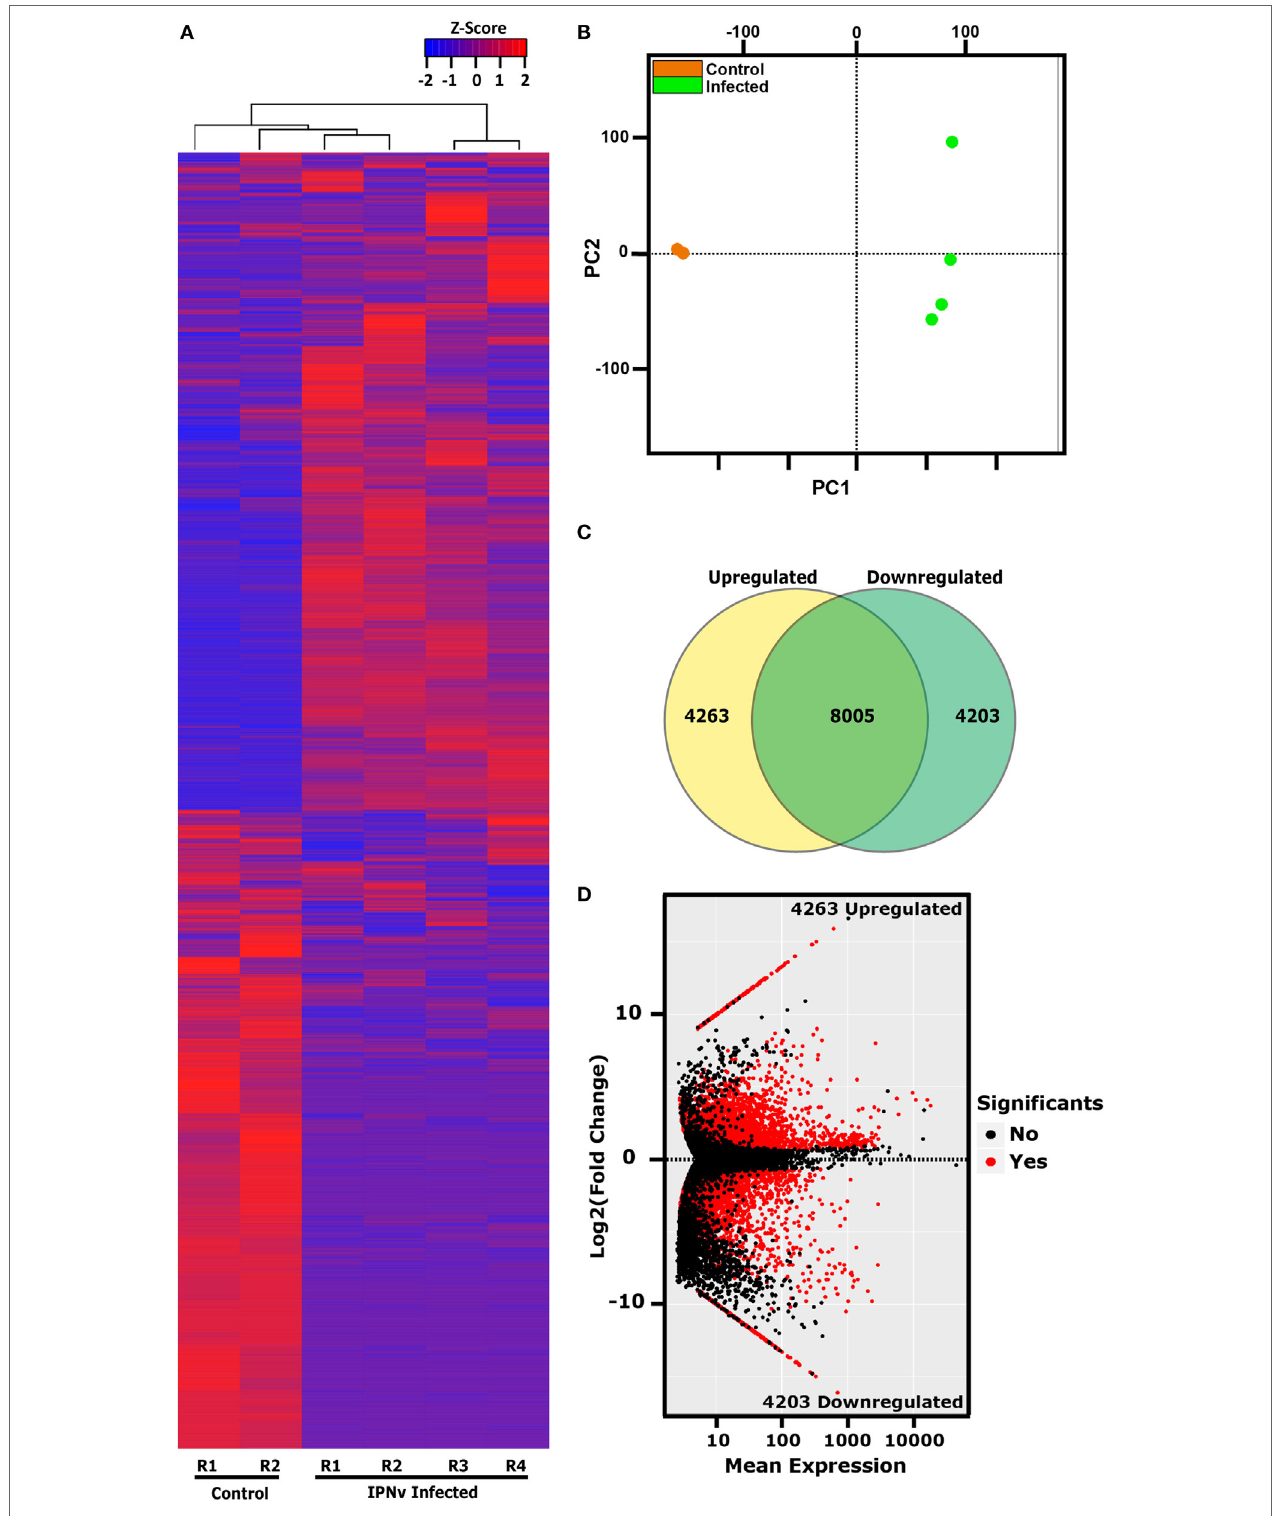
FigUre 4 | Transcriptional dynamics of coding genes in headkidney during infectious pancreaticc necrosis virus (IPNv) infection. (a) Gene expression clustering of the 16,470 genes expressed on headkidney. (B) Principal component plot (PCA) of sample replicates (orange = control samples and green = infected samples). (c) Venn diagram indicating the number of differentially expressed genes. (D) MAplot (average expression vs. fold of change) displaying all differentially expressed genes induced by IPNv